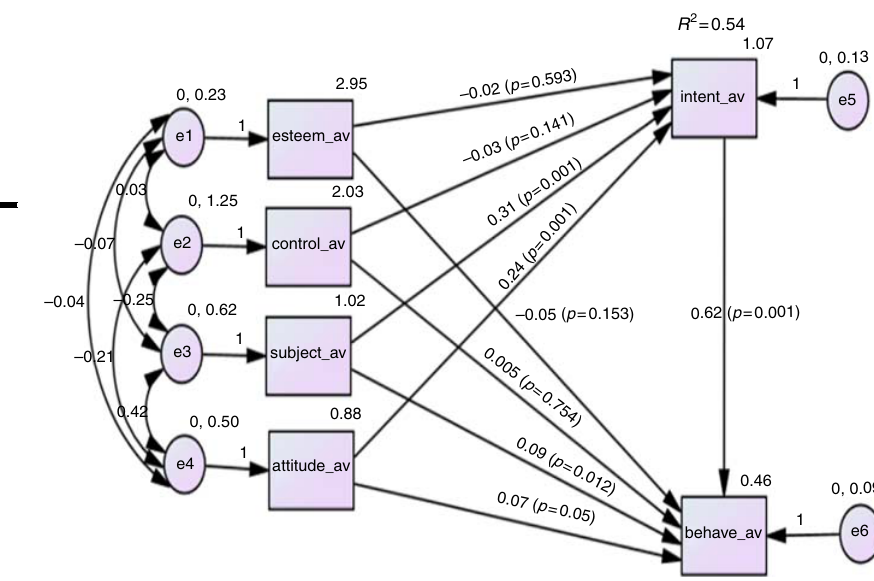
Figure 2. Model of cyberbullying behavior after